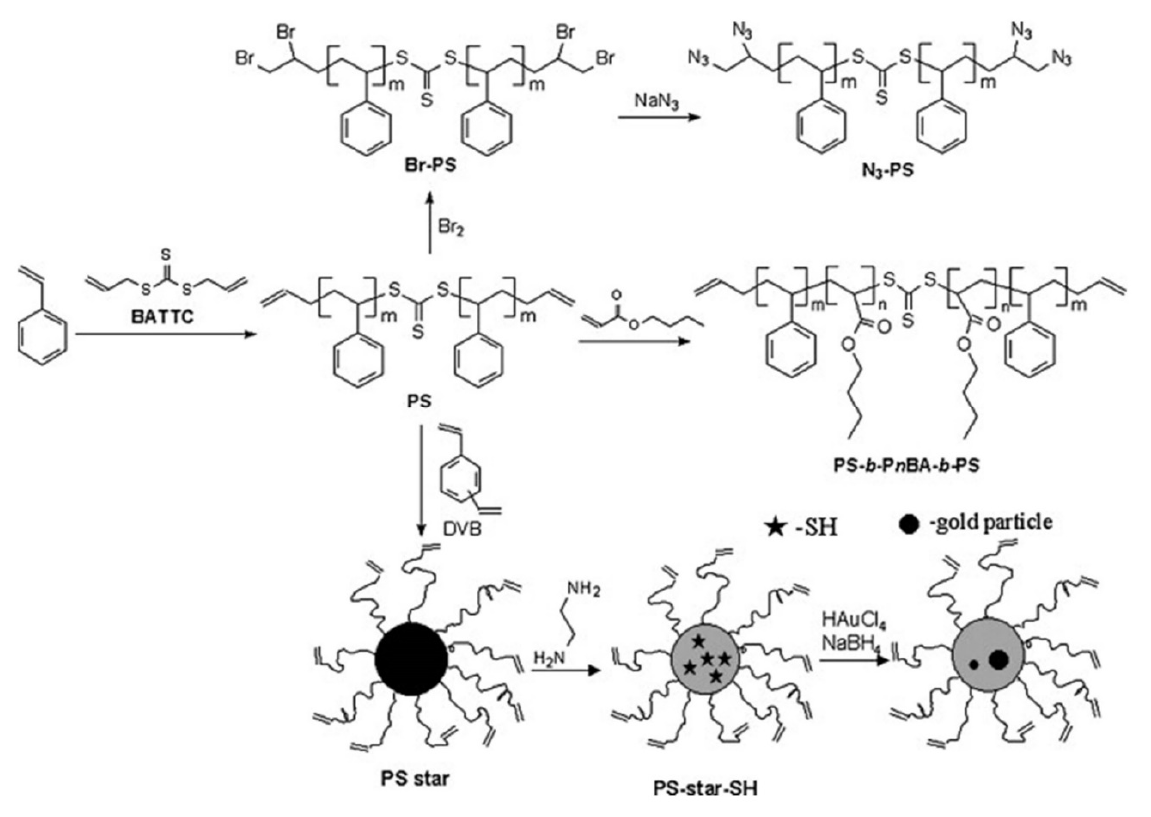
Figure 23. The synthesis route of bisallyl-functionalized telechelic polymers and star polymer and their properties thereof, with BATTC mediated RAFT polymerization as described by Zhang et al. Reprinted with permission from [44]; published by Elsevier, 2006.